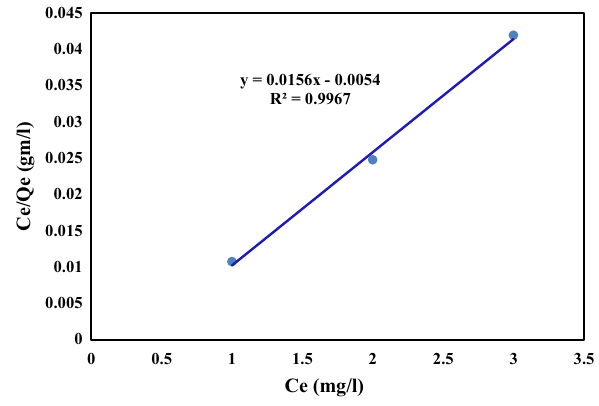
Fig. 11 Langmuir isotherm of MG by NLP (adsorbent: 3 g/l, pH: